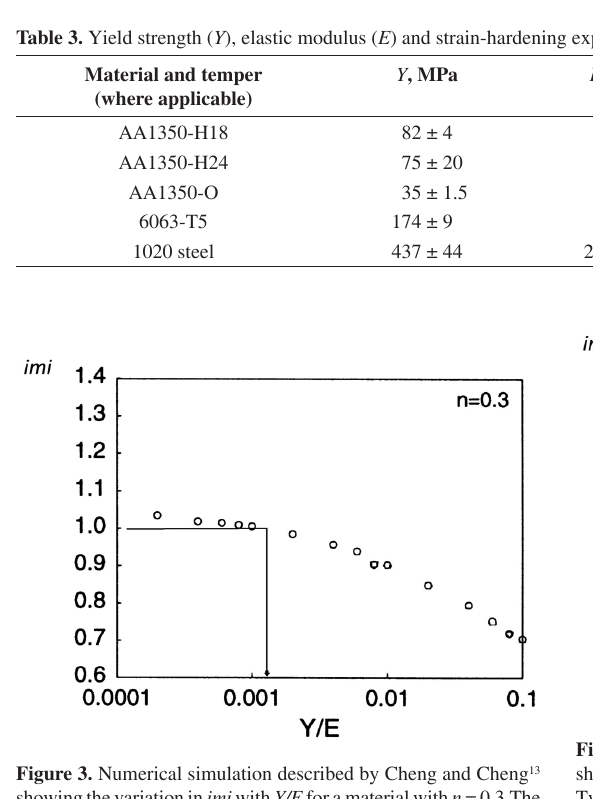
Figure 3. Numerical simulation described by Cheng and Cheng 13 showing the variation in imi with Y/E for a material with n = 0.3.The experimental value of Y/E corresponding to imi = 1.0 is marked.